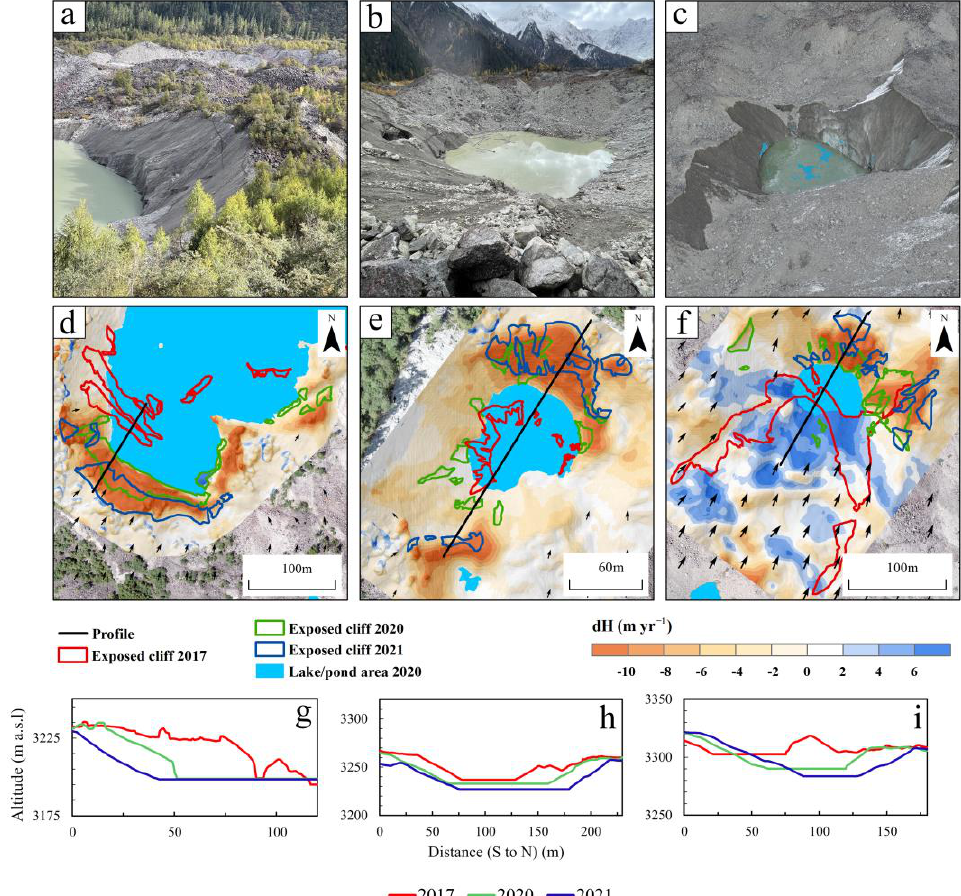
Figure 7. ( a , b ) The photos of hotspot A and hotspot B, taken in October 2021. ( c ) The point cloud model of hotspot C originate from UAV flight in December 2017. ( d – f ) Dynamic change of three different hotspot system showing the surface elevation change during 2020–2021, the evolution of ice cliff, the surface flow vectors, together with the selected topographic profiles during 2017, 2020 and 2021 along hotspot A ( g ), hotspot B ( h ) and hotspot C ( i ). The background image is from the DOM in 2020.